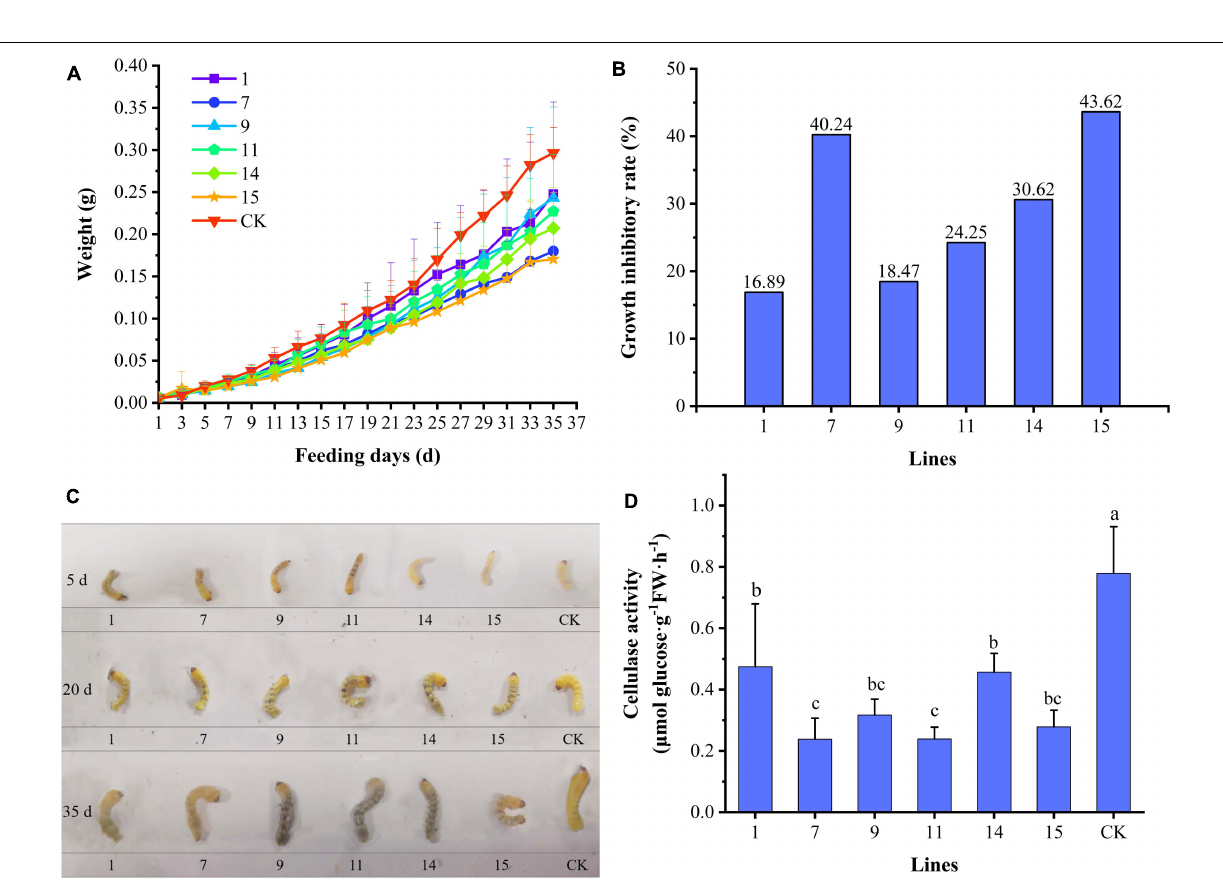
FIGURE 4 | Growth indexes of A . glabripennis larvae. (A) Variation in average body weights of A . glabripennis larvae fed different lines. (B) Rates of growth inhibition in A . glabripennis larvae fed different transgenic lines. (C) Comparison of the larvae fed the different lines. (D) Cellulase activities in the midguts of larvae fed different transgenic